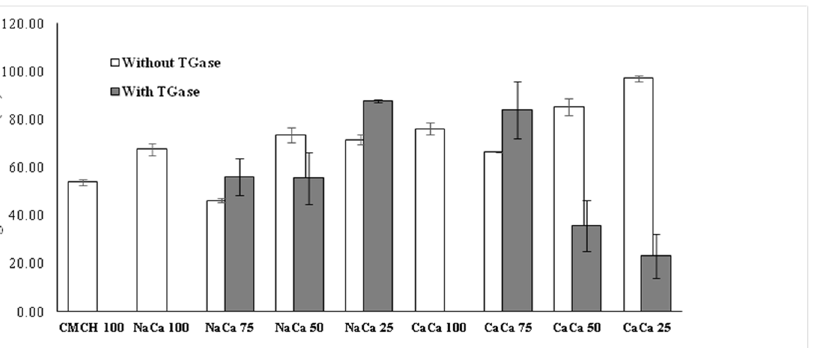
Figure 2. Elongation at break of CA-CMCH composite films [CHCH = carboxymethyl chitosan; NaCA = sodium caseinate, CaCA = calcium caseinate, 100, 75, 50, and 25 represent the proportion of the individual component, the balance out of 100 being CMCH].